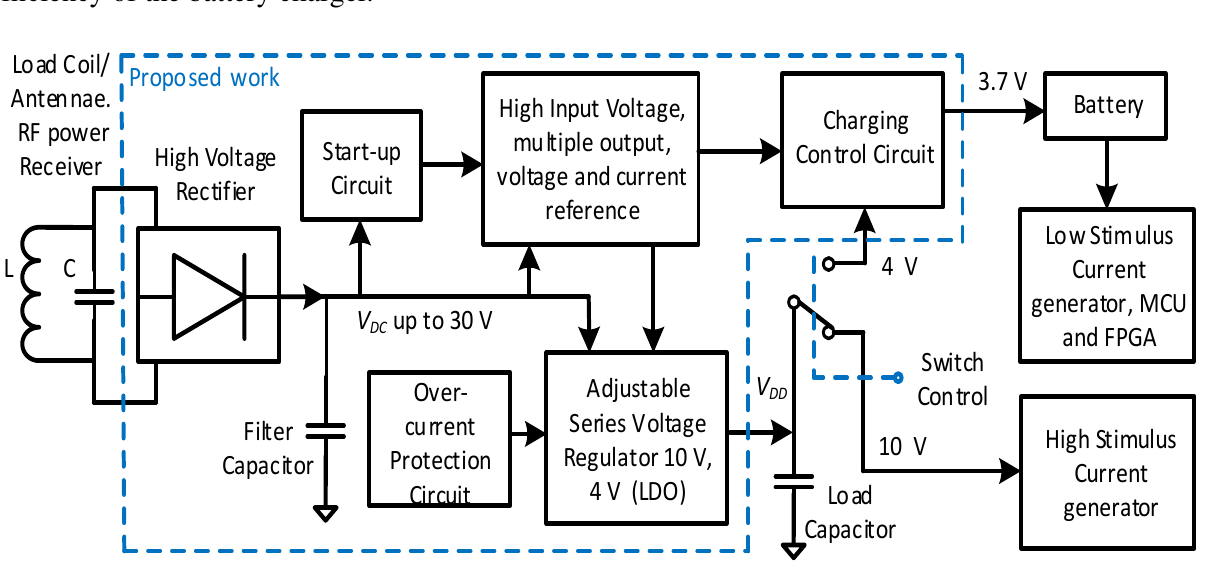
Figure 2. Schematic block of the power recovery topology in the